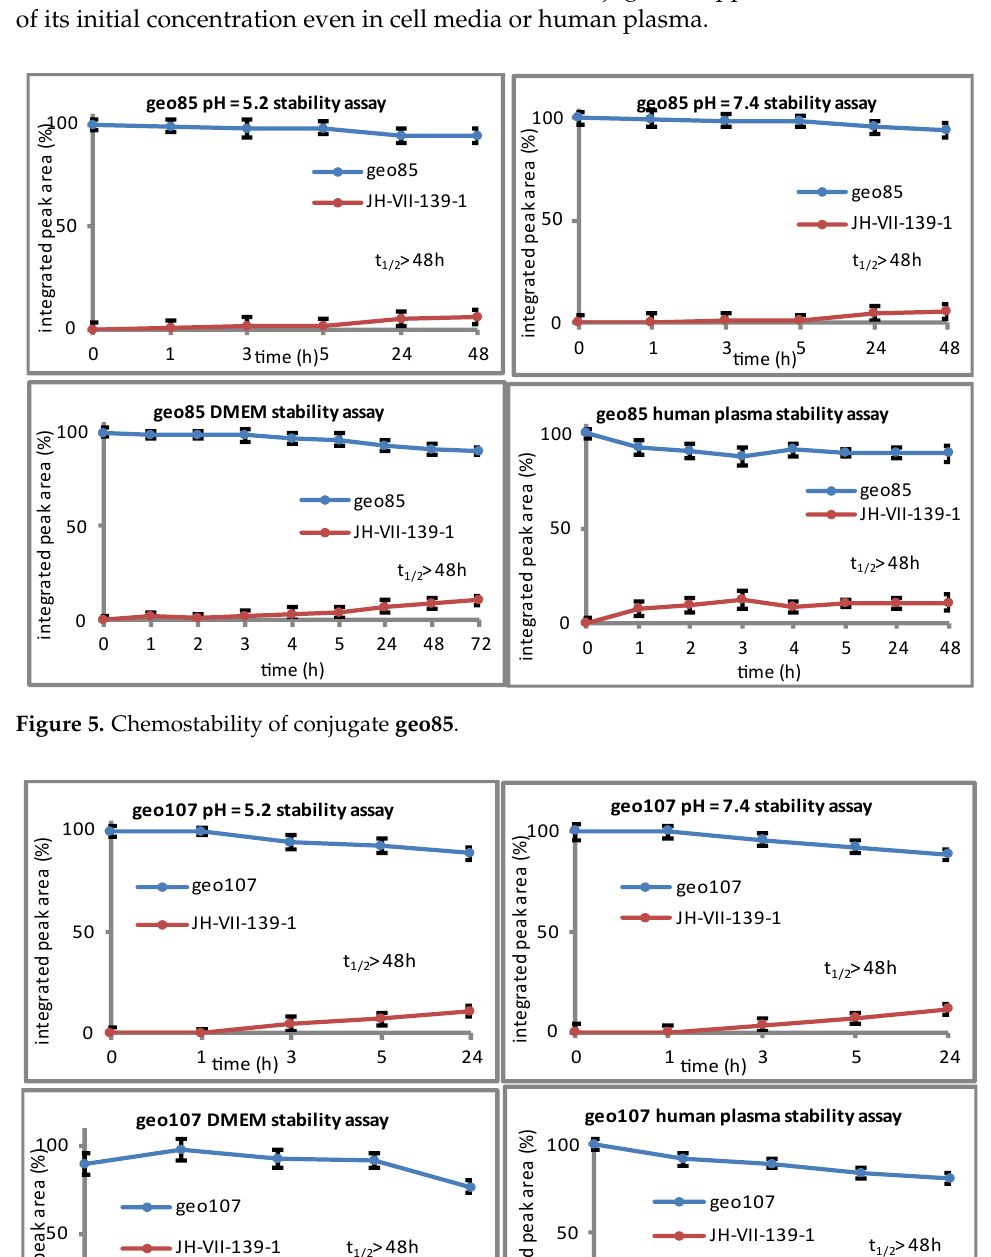
Figure 6. Chemostability of conjugate geo107 .